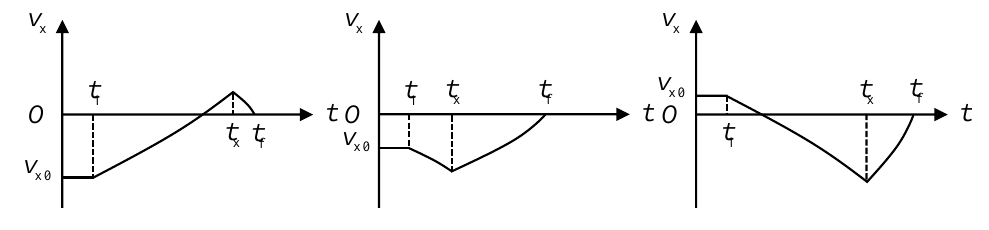
Figure 3. Three motion modes in the X